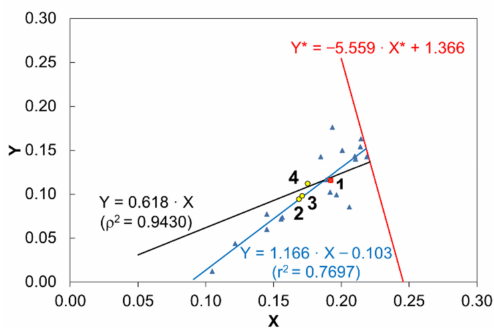
Figure 11. Deliveries of hard and semi-soft coking coals in the system of scales of the grain size triangle, number of samples 19, with the properties of the starting blend and changed qualitative compositions